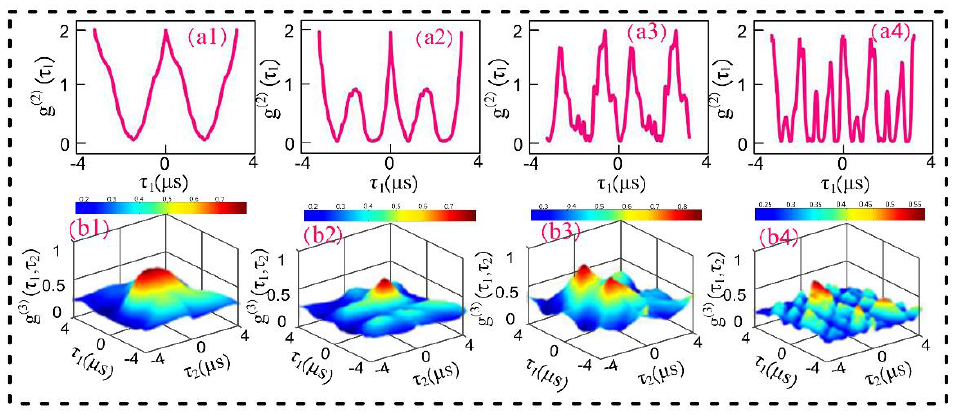
Figure 5. ( a ) The second-order temporal correlation of two pseudo-thermal sources; ( a1 ) S f wavelenth = 575 nm; ( a2 ) S f wavelenth = 576 nm; ( a3 ) S f wavelenth = 577 nm; ( a4 ) S f wavelenth = 578 nm; ( b ) The third-order temporal correlation of two pseudo-thermal sources, the experimental